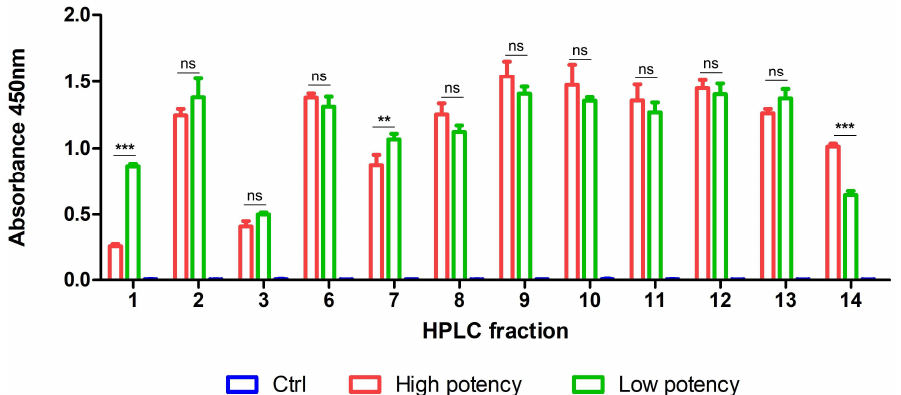
Figure 3. Immunorecognition of fractionated venom proteins by high-potency and low-potency horse plasma samples. A microplate was coated with 14 protein fractions of HPLC-separated D. acutus venom and incubated with both plasma samples, respectively, for indirect ELISA analysis. Each bar represents mean ± SD of triplicates (* p ≤ 0.05; ** p ≤ 0.01; *** p ≤ 0.001; ns: not significant).